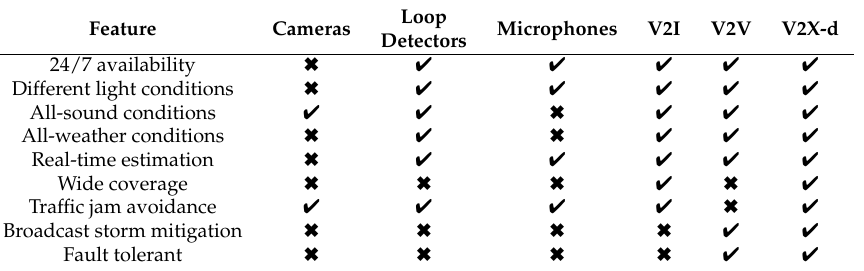
Table 1. Qualitative comparison of density estimation